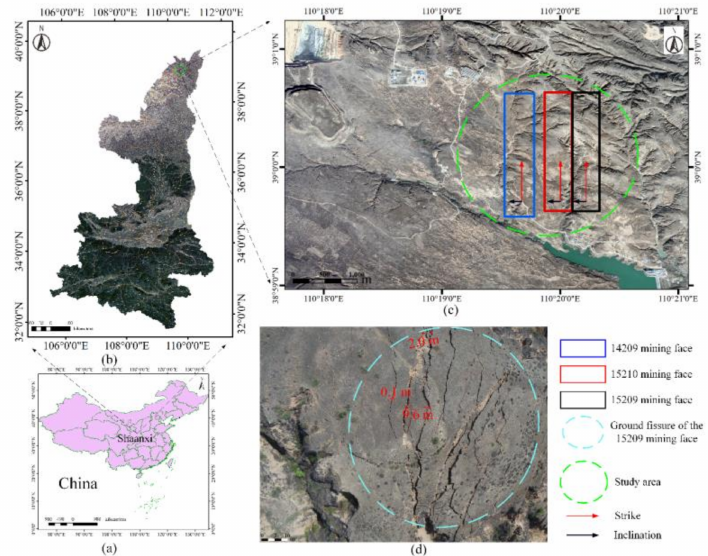
Figure 1. Location and current status of the study area: ( a ) China; ( b ) Shaanxi province; ( c ) The green ellipse is the study area, which includes 14209 mining face, 15209 mining face and 15210 mining face; ( d ) Ground fissure of 15209 mining face. (The base map of ( b , c ) is Google Earth; ( d ) is a UAV aerial photo).